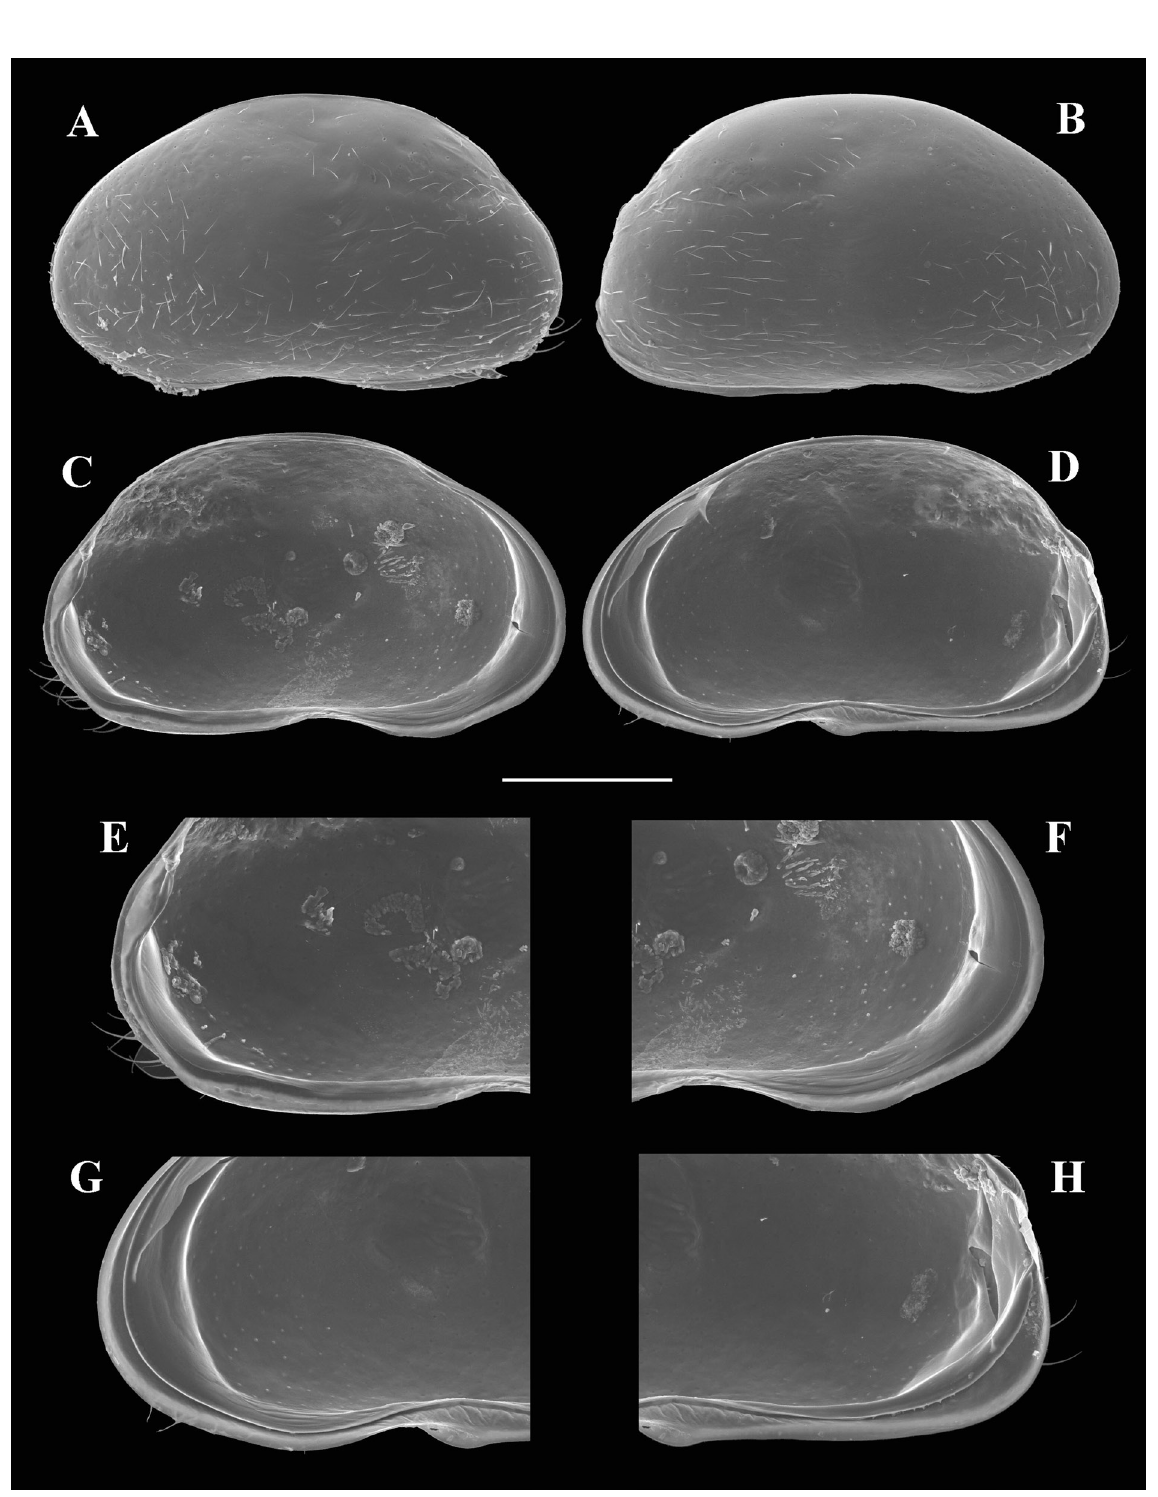
Fig. 11. Siamopsis khoratensis gen. et sp. nov., ♀ (MSU-ZOC.204). A . LVe. B . RVe (idem). C . LVi (idem). D . RVi (idem). E . Posterior part of LVi (idem). F . Anterior part of LVi (idem). G . Anterior part of RVi (idem). H . Posterior part of RVi (idem). Scale bar: A–D = 200 μ m; E–H = 140 μ